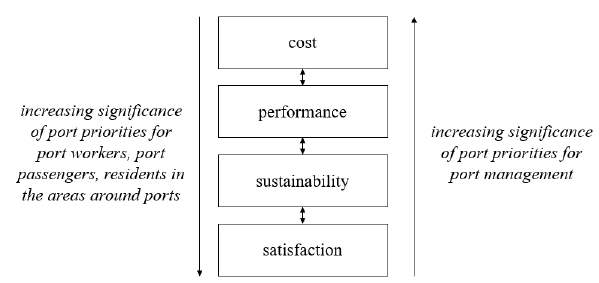
Figure 2. Competing Port Stakeholder